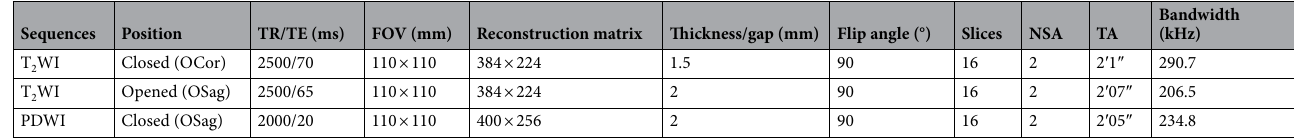
Table 1. Acquisition parameters of the applied MR